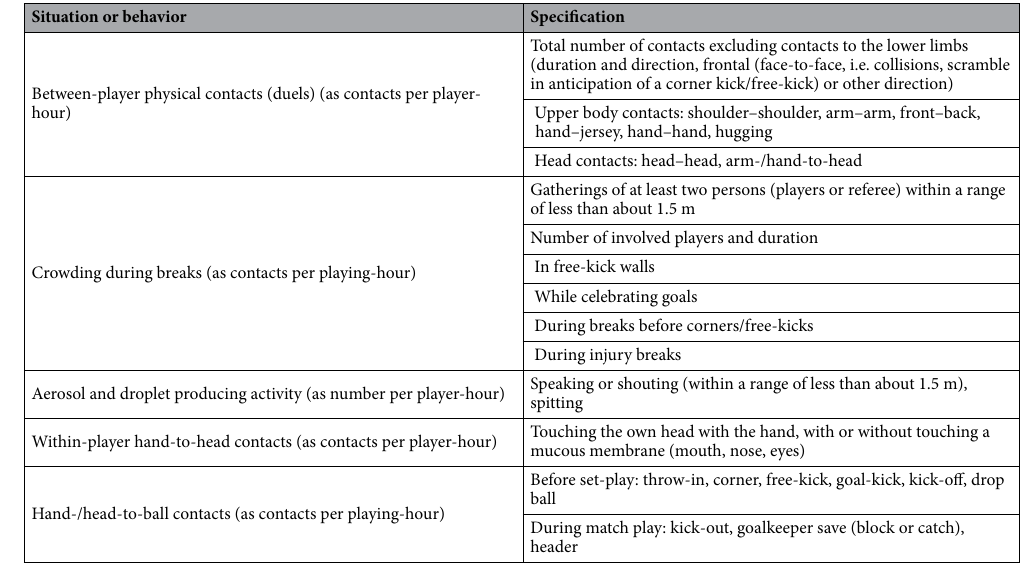
Table 1. Definitions of risk situations and risk behavior during football